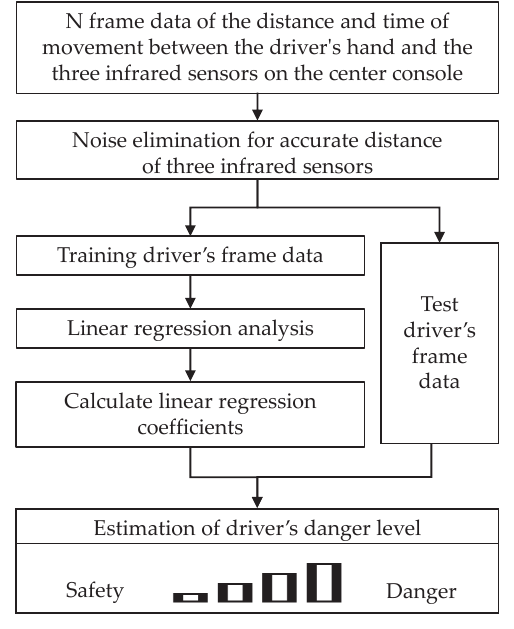
Figure 1. The proposed driver’s danger level estimation approach.